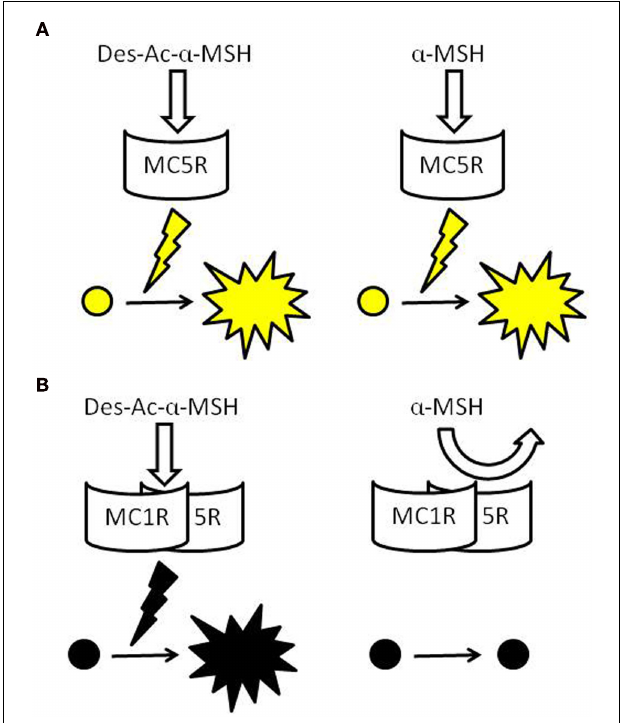
FIGURE 1 | Schematic models of the pigment-dispersing activities of α -MSH-related peptides via MCRs. Both Des-Ac- α -MSH and α -MSH stimulate pigment dispersion when one type of MCR is expressed in chromatophores, such as in xanthophores of bf flounder, Jpn flounder, and goldfish (A) . Des-Ac- α -MSH also exhibits activities in chromatophores expressing two types of MCRs, such as in the melanophores of bf and Jpn flounders, but α -MSH does not. α -MSH may have low affinity to putative MCR heterodimers (B)